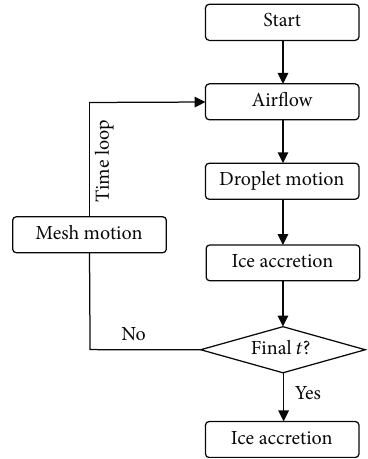
Figure 1: Interactive loop of the proposed numerical